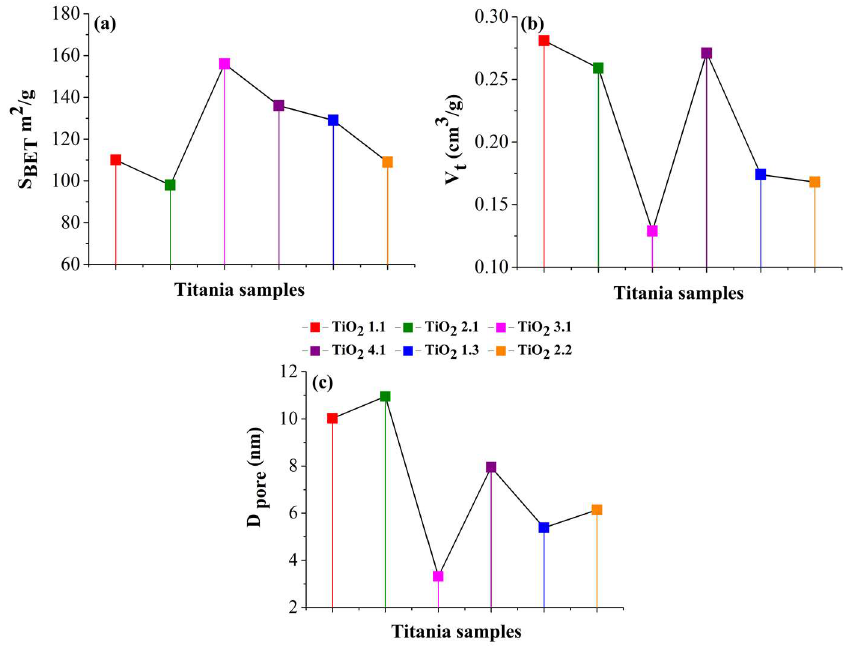
Figure 4. Influence of ultrasonication regime on textural parameters as ( a ) specific surface area ( b ) total pore volume and ( c ) pore size distribution of the prepared titania samples.